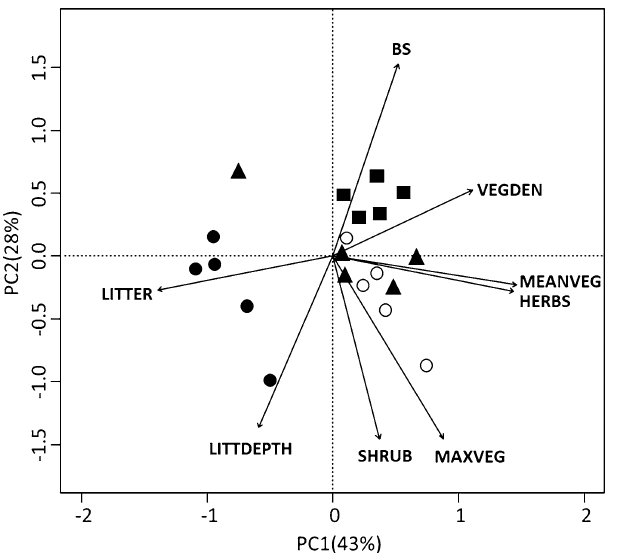
Figure 2. Biplot representing the first (PC1) and second (PC2) axes of principal component analysis, showing ordination of sites according to environmental variables measured in cattle fields (triangles), soybean crops (squares), seminatural grasslands (white circles), and tree plantations (black circles). Environmental variables are percentage coverage by shrubs (SHRUBS), herbaceous vegetation (HERBS), leaf litter (LITTER), and bare